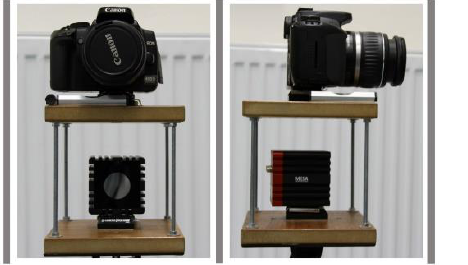
Figure 1. The Proposed System’s setup (front view, side view) In figure 2 the range camera coordinate system is presented.